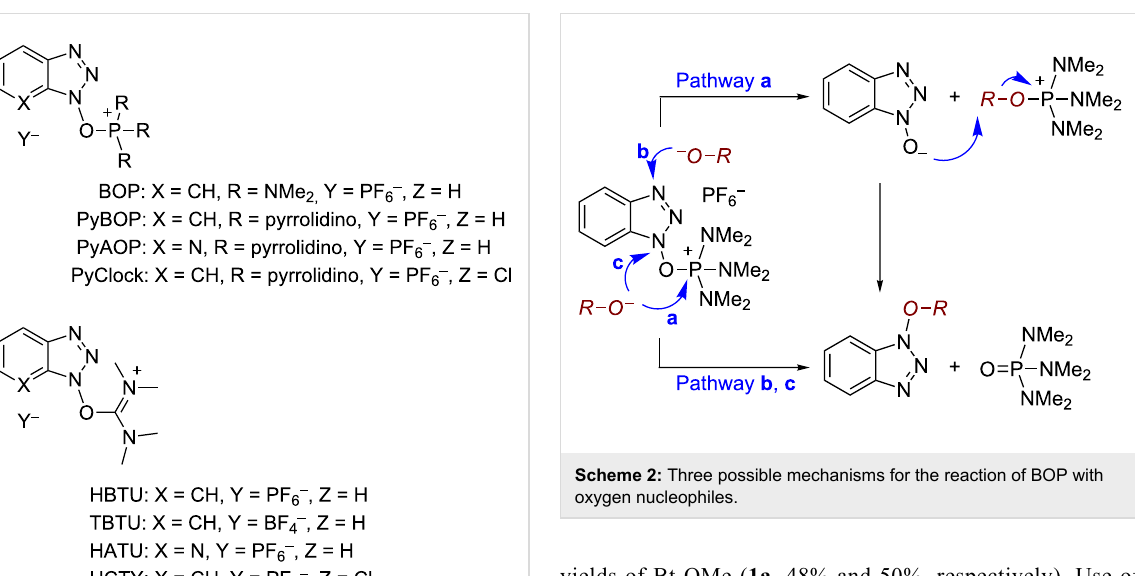
have demonstrated the isolation and synthetic utility of a nucleoside phosphonium salt [28]. Thus, to us the reaction of oximes with BOP was an intriguing result, leading us to query whether a benzotriazolyl intermediate, rather than a phospho- nium ion, was formed en route to the cyanide. This line of reasoning would then suggest that 1-alkoxy-1 H -benzotriazoles may indeed be obtainable from the reactions of alcohols with BOP, and that different reaction pathways may be operative depending upon the nature of the nucleophile (Scheme 2).